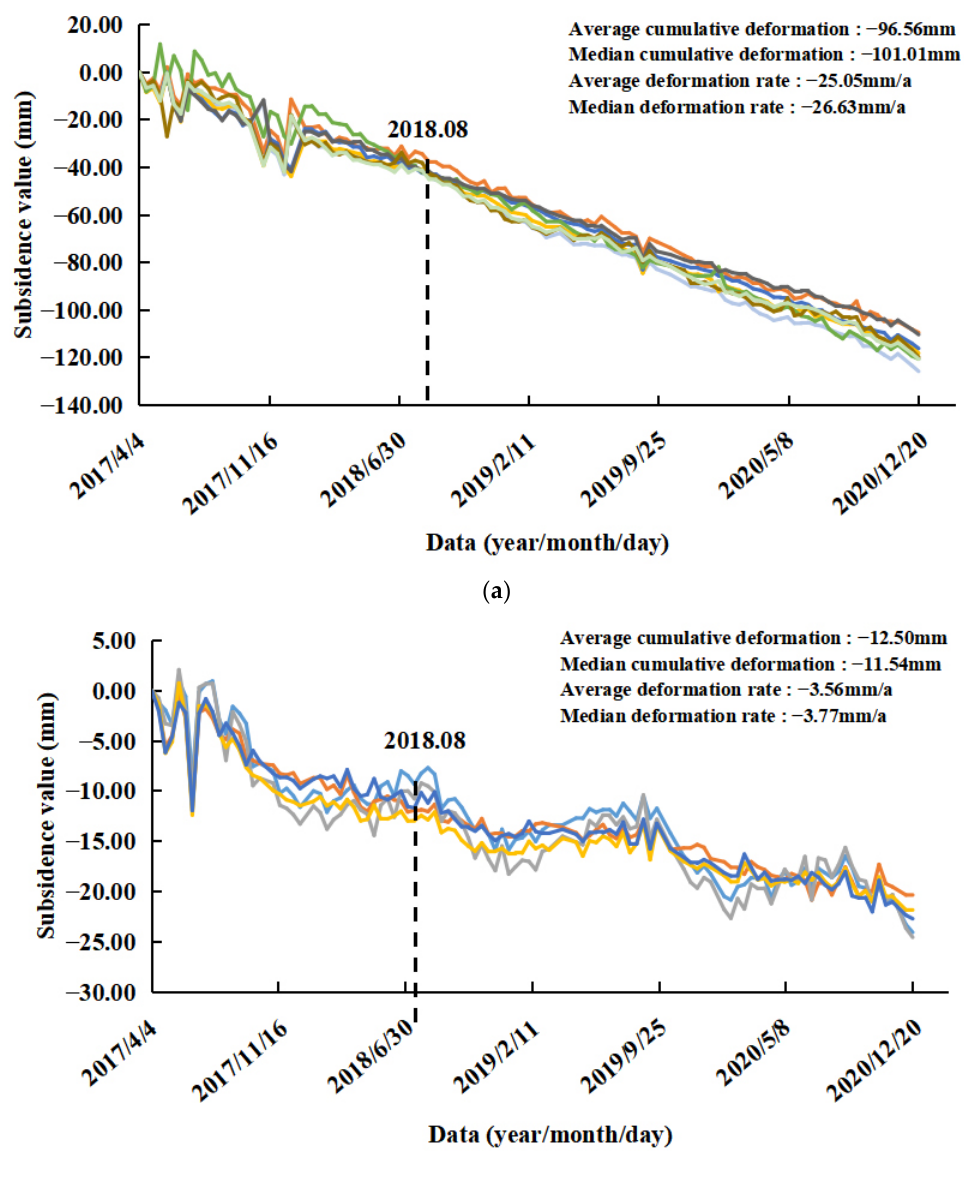
Figure 11. Part of the PS points subsidence: ( a ) the area to the south of the Health Center Station and ( b ) the area along the subway line from the Hongdao Railway Station to the Health Center Station. (Different colors represent different PS points).